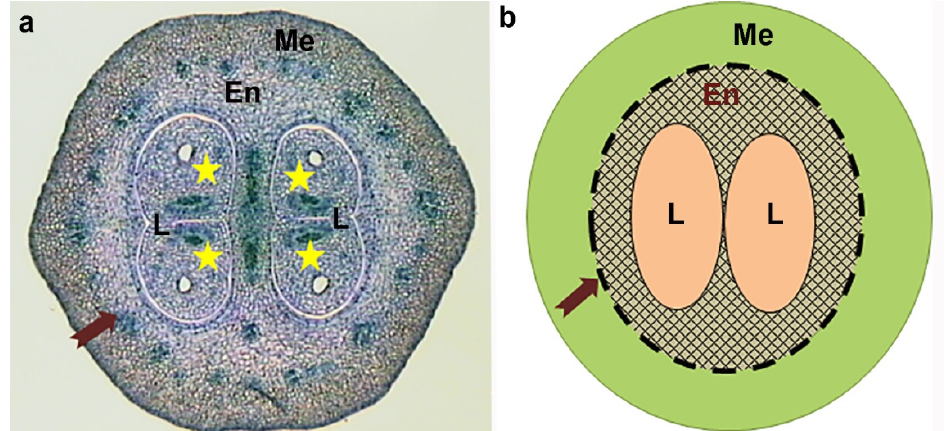
Figure 3. Central transverse section of olive ovary at bloom ( a ) and diagram showing the measured structures ( b ). The mesocarp (Me) and endocarp (En) are separated by a ring of vascular bundles (arrow); the two locules (L) each contain two ovules (star).